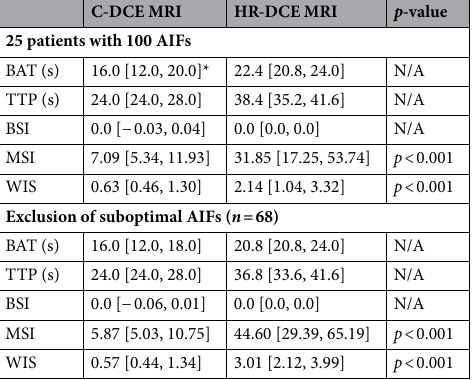
Table 3. Comparison of AIF parameters derived from C-DCE and HR-DCE MRI. BAT bolus arrivial time, TTP time to peak, BSI baseline signal intensity, MSI maximal signal intensity, WIS wash-in slope, N/A not applicable. *Median[Interquartile